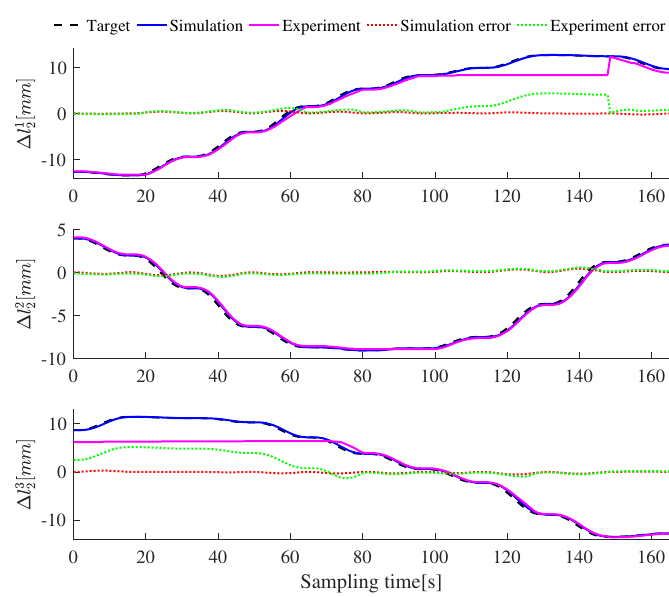
~ ∆ l 3 in segment 1. 1 1